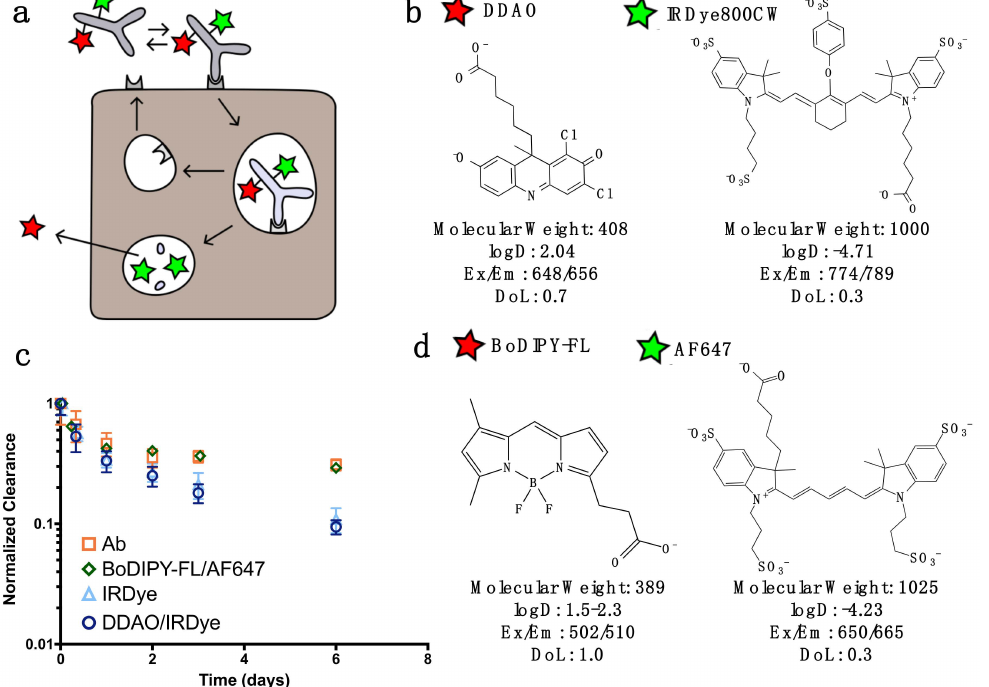
Figure 1. Dual label near-infrared (NIR) fluorescence imaging technique concept. ( a ) Graphic depiction of dually labeled antibody binding the cell, internalizing, and degrading. The non-residualizing DDAO (red star) leaks out of the cell following protein degradation, while the residualizing IRDye (green star) is trapped. ( b ) DDAO and IRDye dye chemical structures, molecular weights, maximum excitation / emission, and logD (pH 7.4) calculated by MarvinSketch. ( c ) The plasma